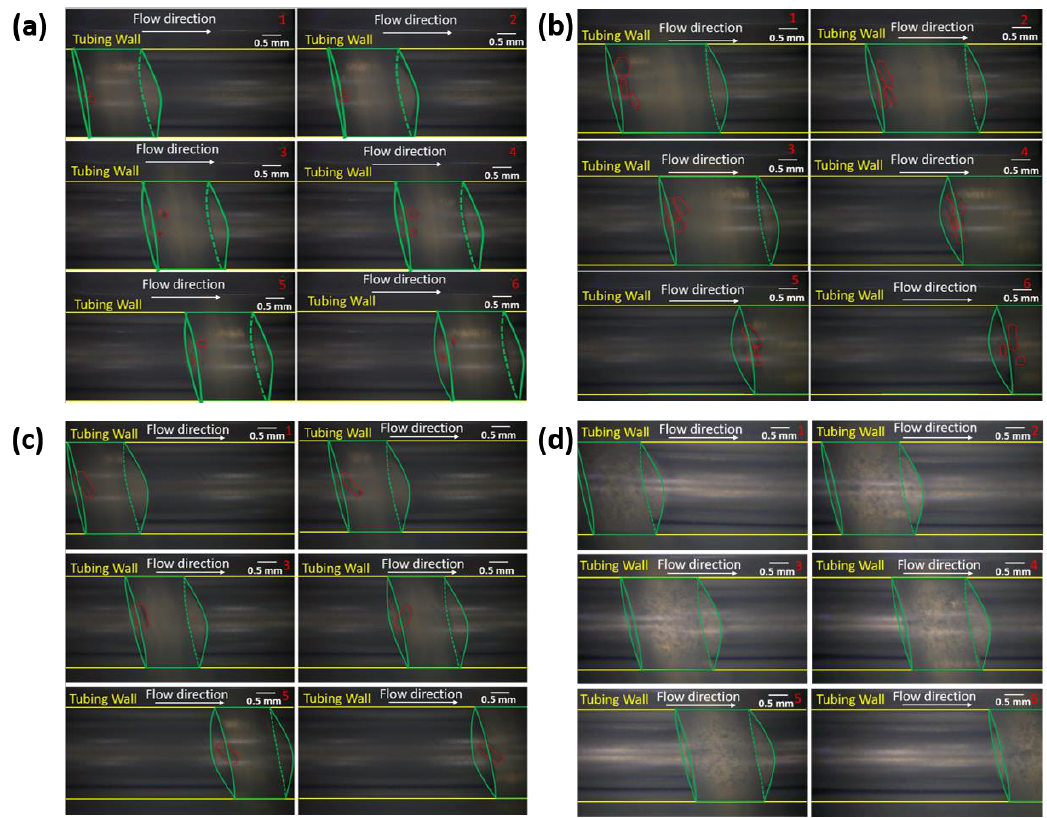
Figure 8. Frame to frame image of slug flow under Conditions ( a ) 1, ( b ) 2, ( c ) 3, and ( d ) 4. The interval between adjacent images is 1 / 30 s. The flow direction is from left to right. Slurry slug and crystals are delineated approximately. Except for Condition 4, the small dark particles inside the slug are glycine crystals. The crystals size and location variation from frame to frame indicate that the crystals were circulating in the tail end region of each slug. Some delineated particles seem out of the slurry periphery because of the relative position variation between the microscope and slug. Scale bar is 0.5 mm.